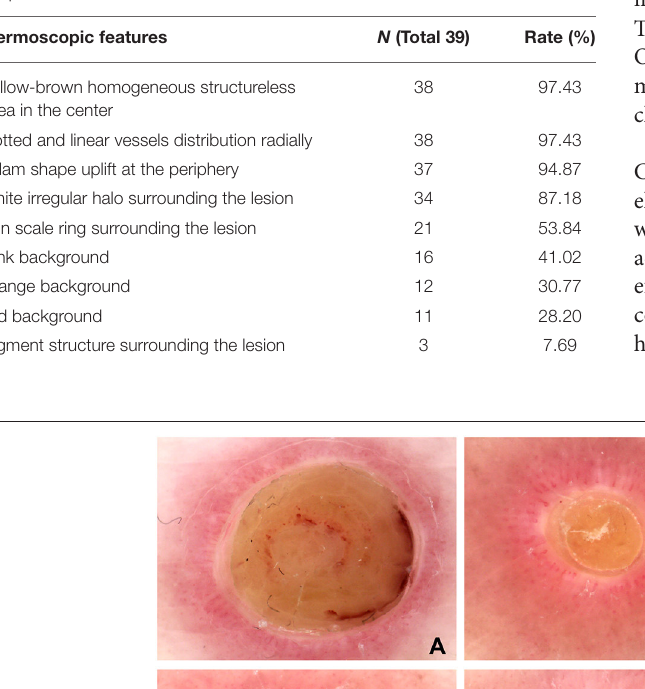
Frontiers in Medicine |